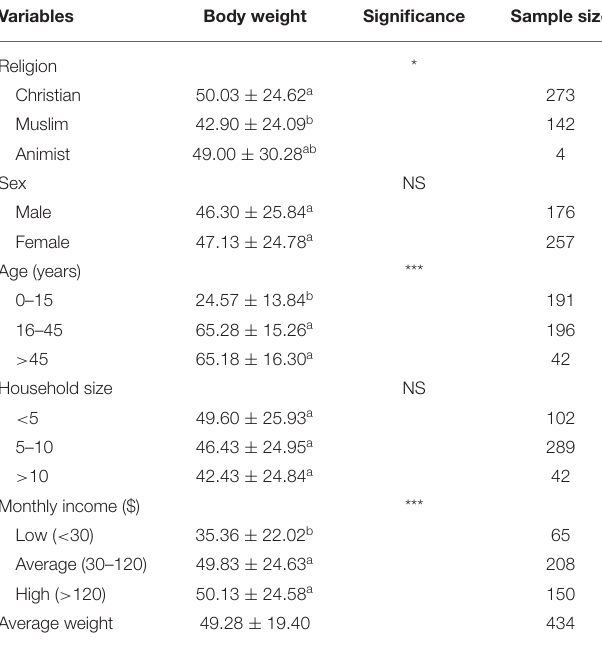
TABLE 1 | Average body weight (in kilograms) of individuals according to their socioeconomic and demographic characteristics. Variables Body weight Significance